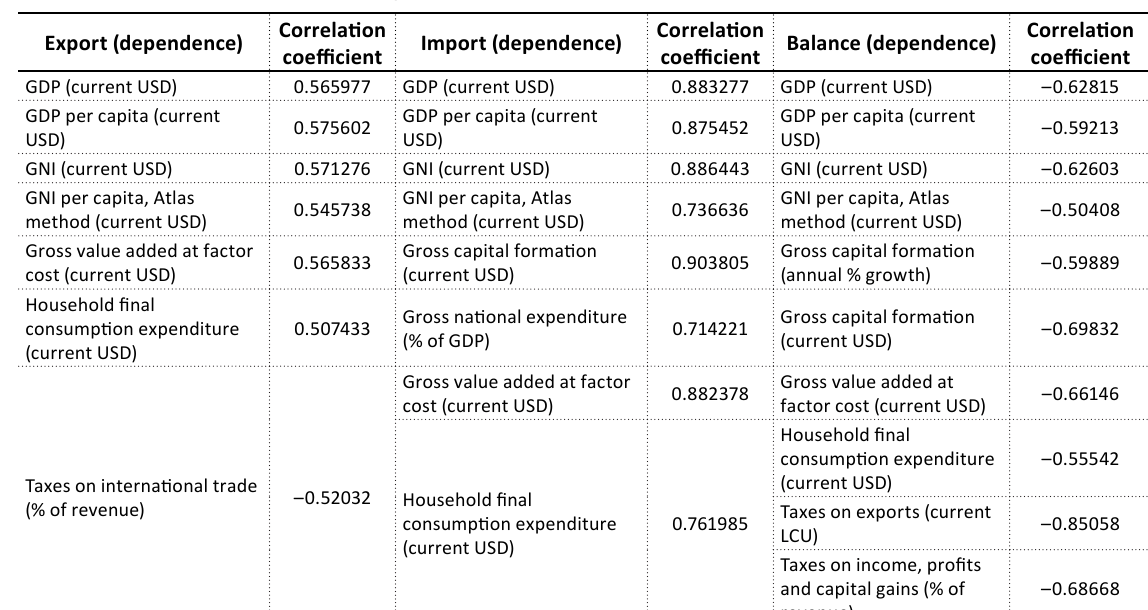
Table 6. Coefficients of the correlation of the indicators of balance, export and import from Ukraine to the United Kingdom with the researched indicators Source: Authors’ calculations according to the data from the State Statistics Committee of Ukraine, the National Bank of Ukraine, the World